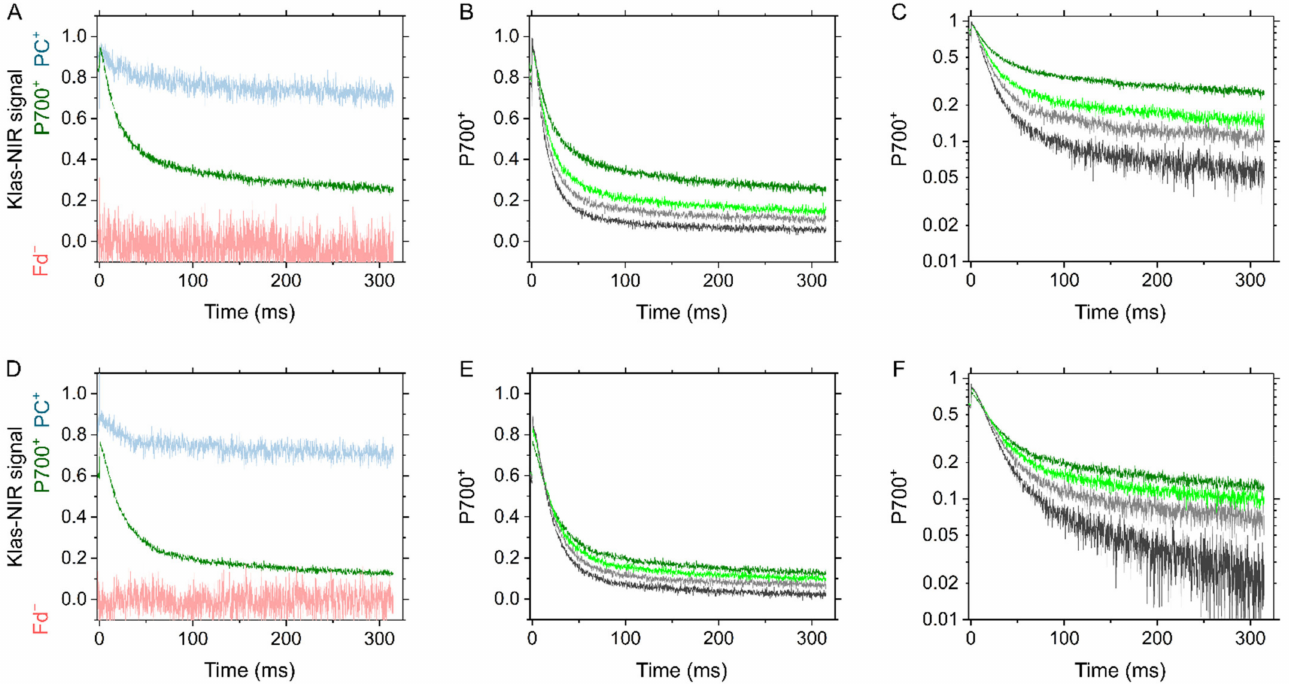
Figure 10. Effects of a short-saturation flash on the redox state around PSI in the C 3 plant mustard ( A – C ) and the C 4 plant maize ( D – F ). ( A , D ) Reduction kinetics of P700 + (green) in response to a 5 µ s-short saturation flash after far-red light illumination for 10 s. Far-red light was provided at the maximum intensity (20, the value defined by the Walz software). Deconvoluted signals to plastocyanin (PC + , blue) and ferredoxin (Fd − , red) are also shown. All the Klas-NIR signals were normalized within the range from the minimum 0 to the maximum 1. The maximum reduction/oxidation levels of each component were determined as shown in Supplementary Figure S2. The signal to Fd − has negative values. ( B , E ) Reduction kinetics of P700 + by a short saturation flash at different lengths (5, green; 10, light green; 20, light grey; and 50 µ s, grey, respectively) after far-red light illumination for 10 s. The kinetics are also shown with the logarithmic scale at y -axis (C, F). The representative traces of independent experiments ( n = 3, biological replicates) are